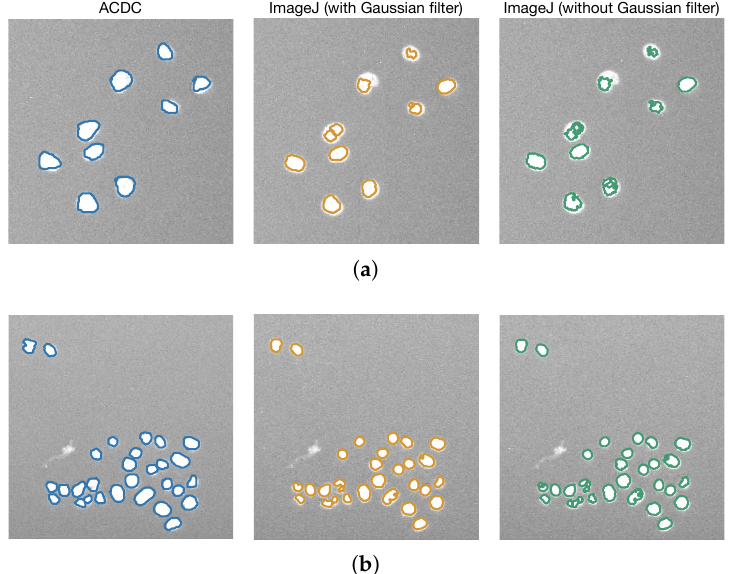
Figure 12. Examples of cell nuclei segmented by using ACDC and the implemented ImageJ pipelines with and without Gaussian filtering. ( a , b ) present images taken from the VU dataset, with different visual